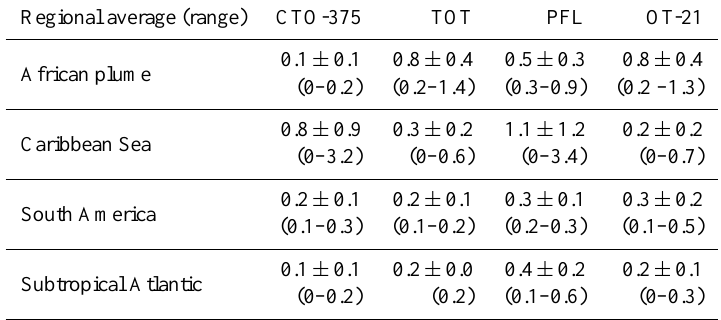
Table 3. Average black carbon concentrations and range by region (µgm − 3 ) using four different methods: the chemothermal oxidation at 375 ◦ C (CTO-375), thermal optical transmittance (TOT), pyrene fluorescence loss (PFL), and optical attenuation